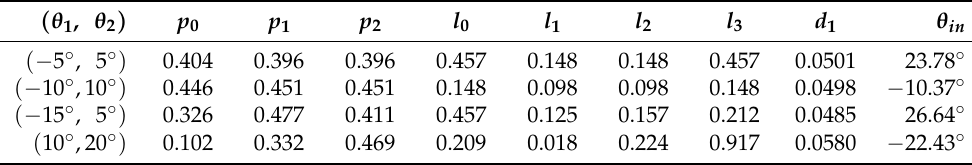
Table 2. The optimum structural parameters for dual-beaming